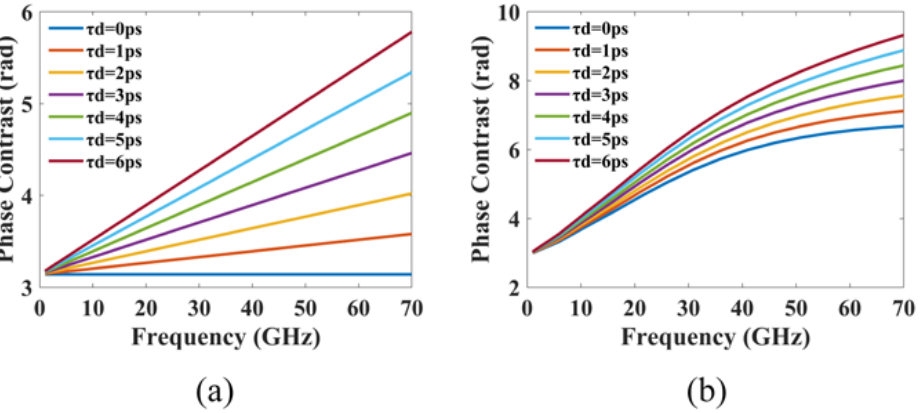
Figure 7. The effect of delay time τ d : ( a ) Phase contrast between injection currents vs. τ d ; ( b ) Phase contrast between modulation responses vs. τ d